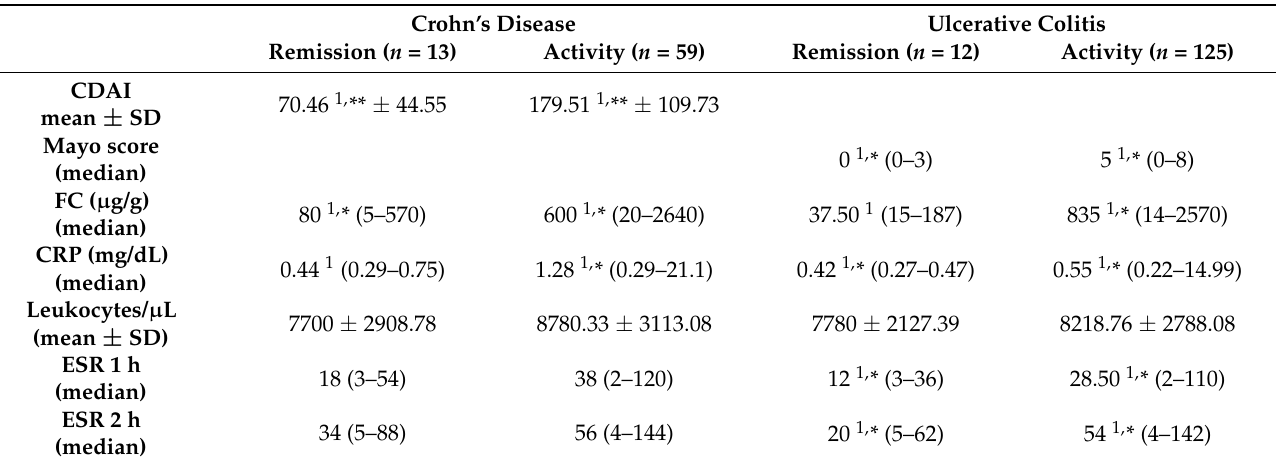
Table 2. Description of non-invasive inflammation assessment parameters according to disease type and